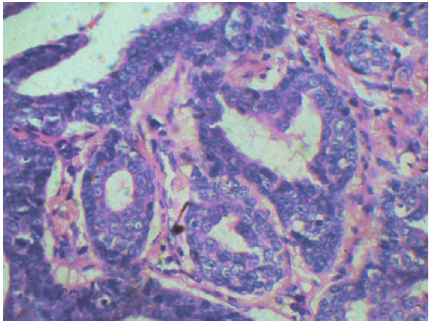
Figure 13: H and E sections showing ductal pattern of arrangement of tumor cells with evidence of vesicular